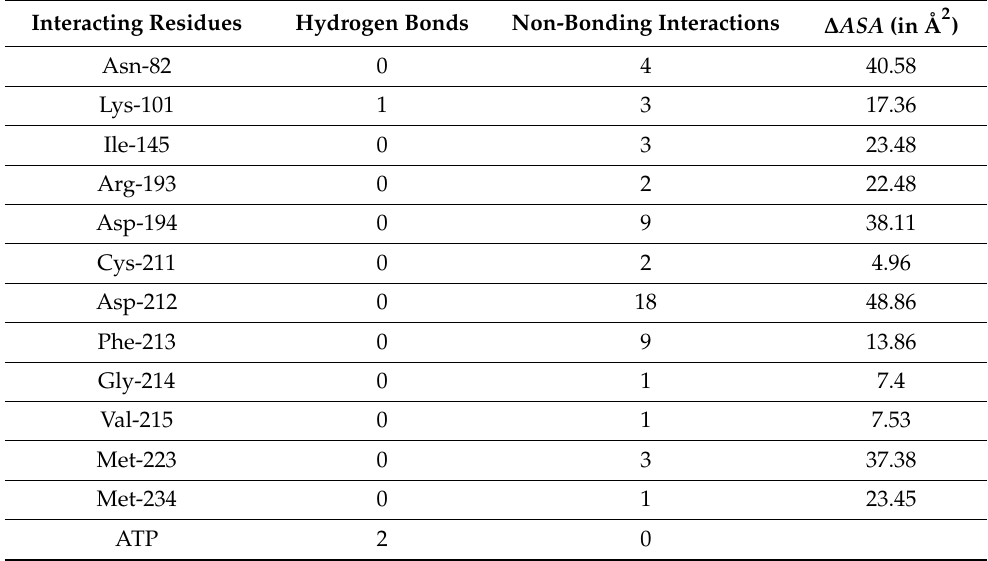
Table A4. The MEK2 residues interacting with selected flavonoid M2F4 are listed with the number of non-bonding interactions and ∆ ASA .